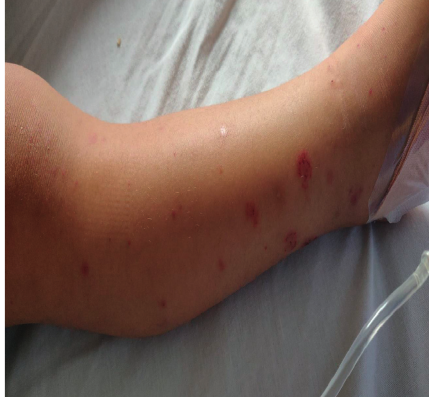
Figure 4: The skin manifestations and joint swelling detected in case